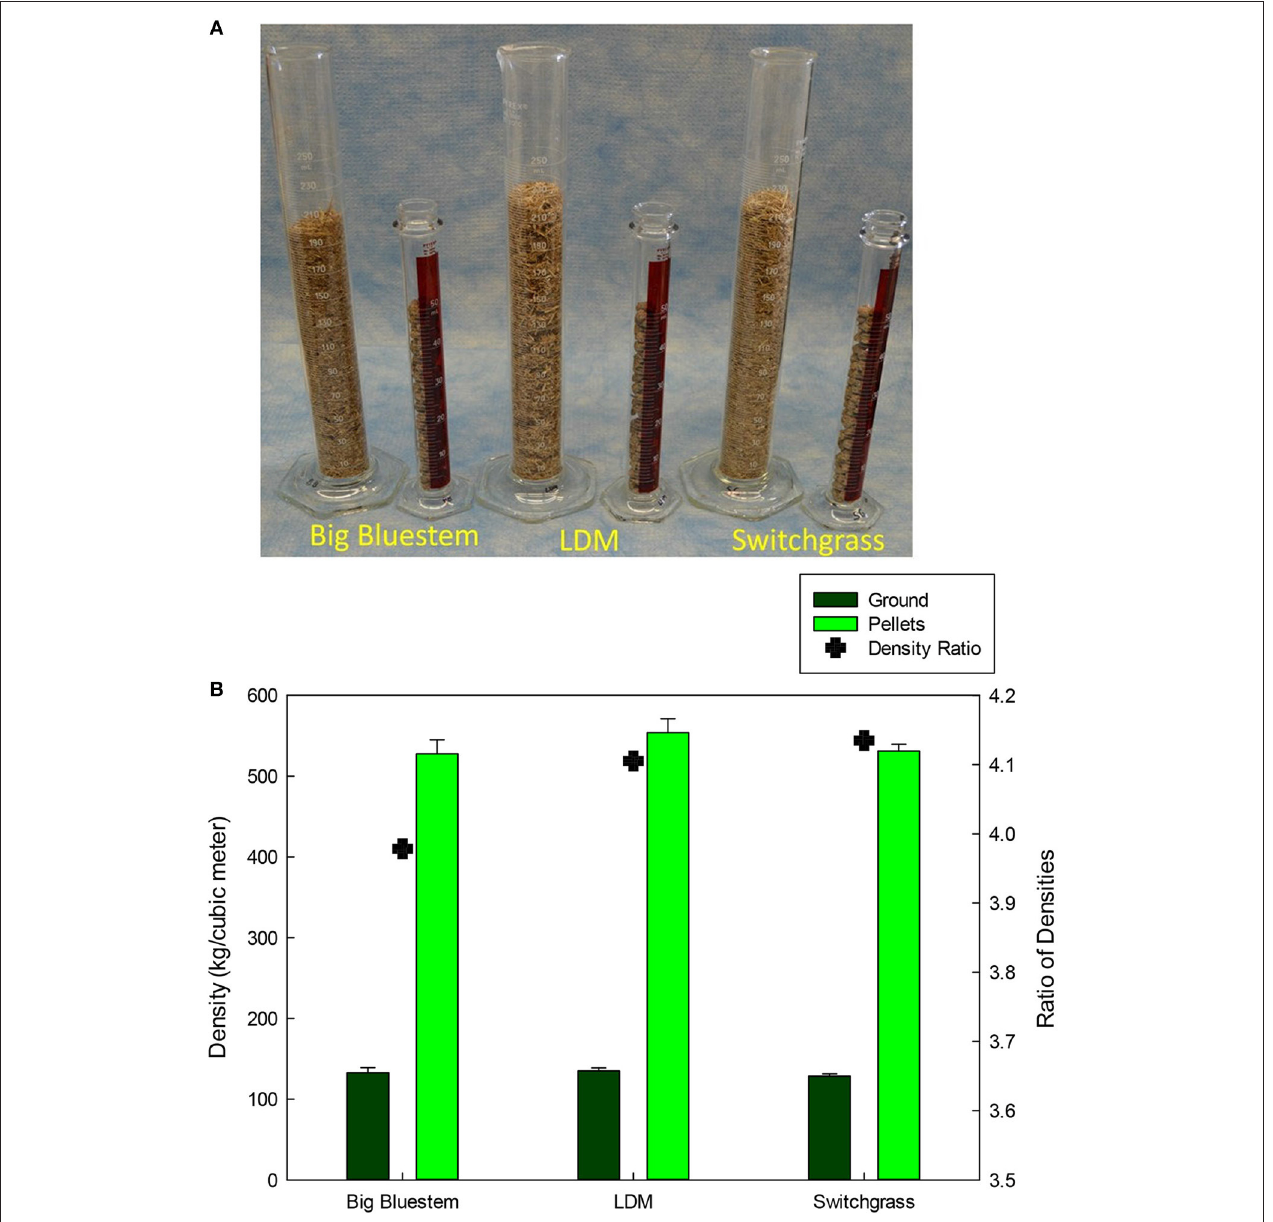
FIGURE 2 | (A) Bulk densities visually compared for 25g of pelletized and coarsely milled grass samples. (B) Graph showing differences in bulk densities between pelletized and coarsely ground samples and among different grasses. Densities were the same across crop and significantly different between pellets and non-pellets (p < 0.001). Legend: dark green is ground; green is pelletized, and cross is the ratio of bulk densities (right hand